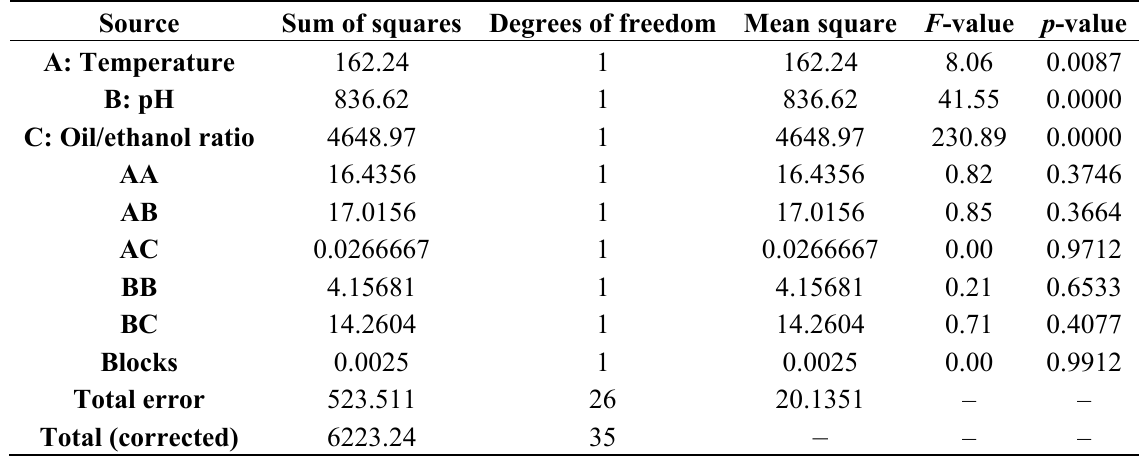
Table 3. Analysis of variance (ANOVA) for Conversion.